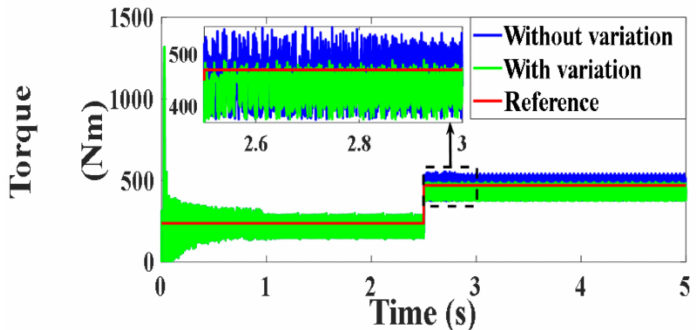
Figure 183. Developed torque under PVC (Nm).